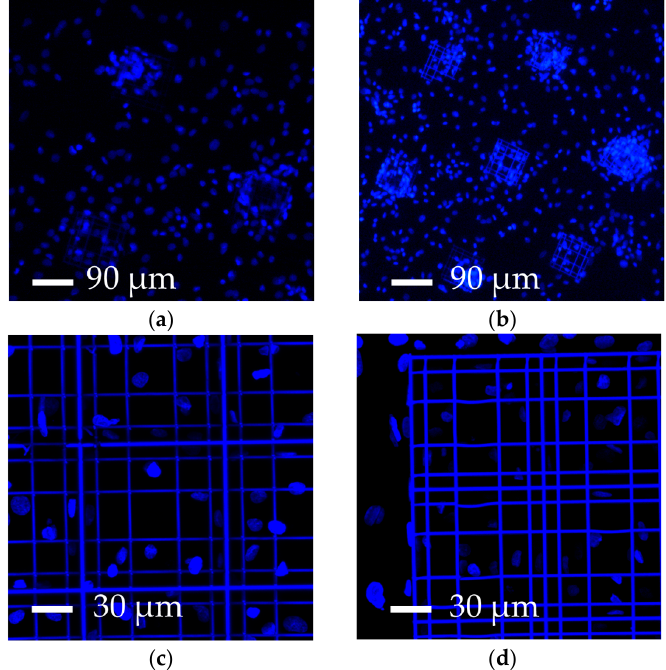
Figure 4. Fluorescence images of cell-populated niche substrates. ( a ) Elementary nichoids patterned in a 200- μ m side triangle; ( b ) The culture substrate of elementary nichoids in a hexagonal layout (300 μ m side); ( c , d ) The culture substrate covered with a fractionated supermatrix of nichoids (FSN), including 218 matrixes at a distance of 30 μ m. Nuclei are stained in DAPI (blue).